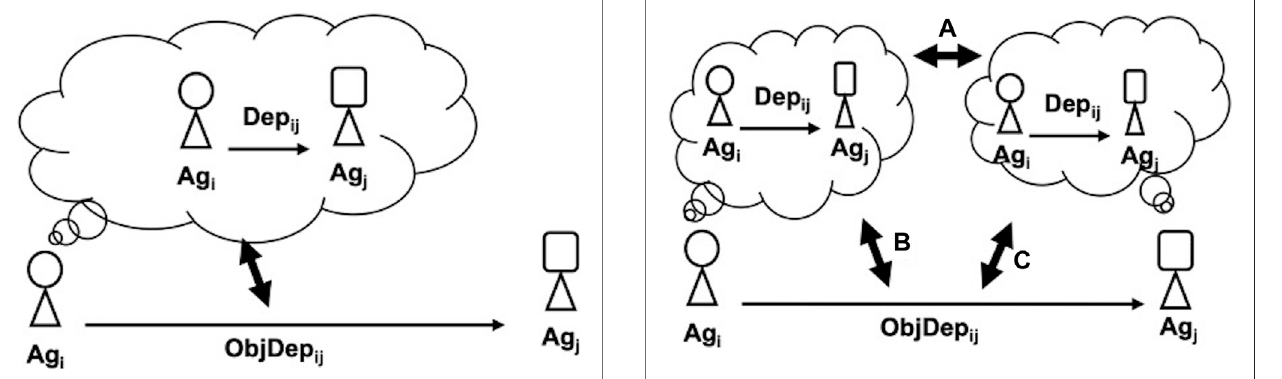
FIGURE 3 | Dependence of Ag i from Ag j on the task τ . (A) comparison onhowitisbelievedbyAg i andbyAg j ; (B) comparisononhowitisbelievedby Ag i and objective reality; (C) comparison on how it is believed by Ag j and objective